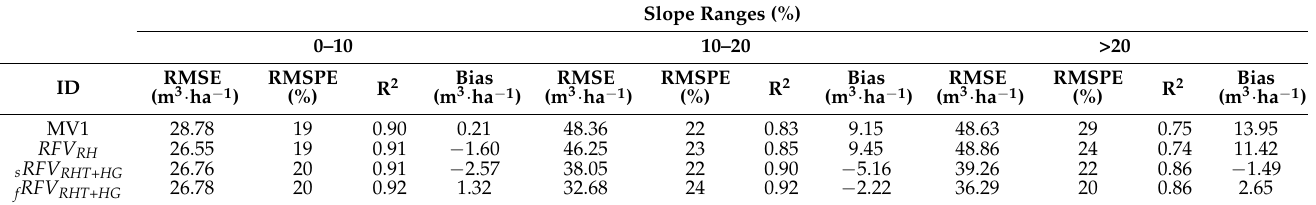
Table 5. Model performance for the estimation of Eucalyptus wood volume. The models are described in Section 3.2. Bias = estimated V-in situ V.